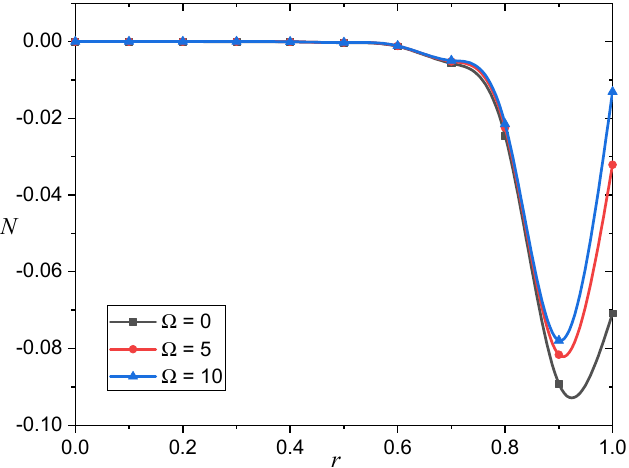
Figure 8. The displacement variation u for different rotation parameter Ω .